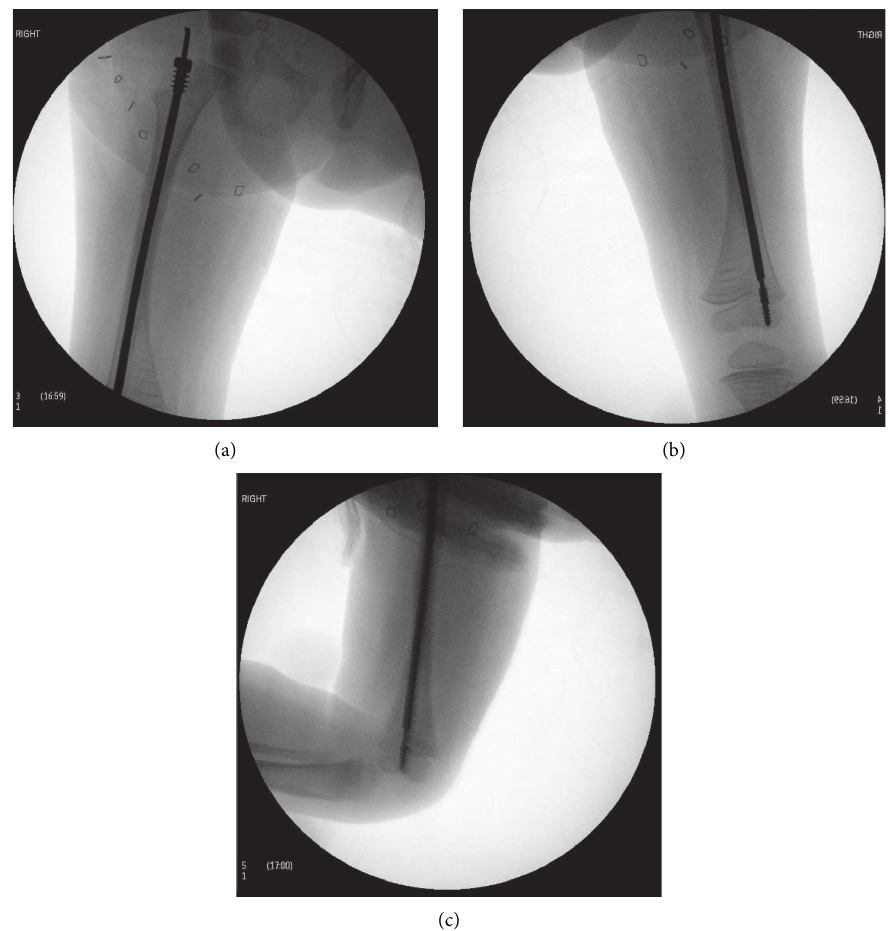
Figure 4: (a)–(c) AP and lateral radiographs of the 4 mm Fassier–Duval rod in place following removal of the fractured 3.2mm male retrieval shaft and